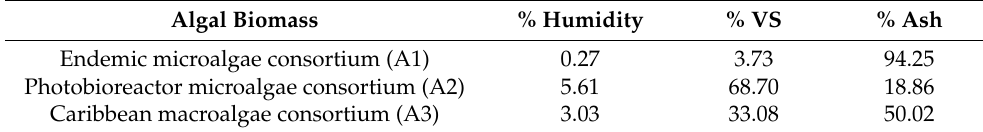
Table 2. Proximate analysis of biomasses by TG. Algal Biomass % Humidity % VS % Ash Endemic microalgae consortium (A1) 0.27 94.25 Photobioreactor microalgae consortium